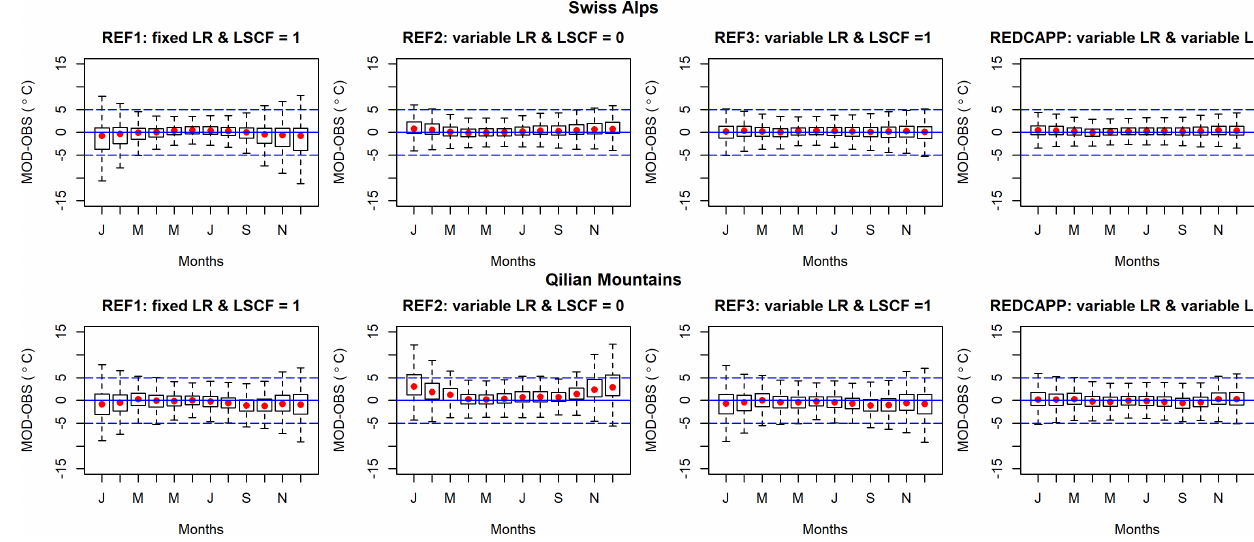
Figure 11. Seasonal deviance of downscaled daily results (MOD–OBS) for different methods. Red dots are median